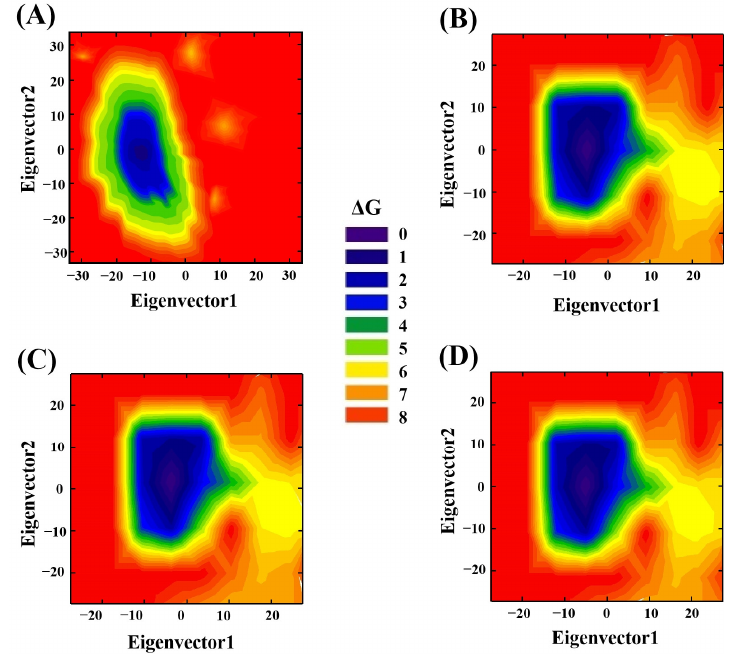
Figure 8. Principal component analysis (PCA) of single amylose molecule ( A ), complex1 ( B ), complex2 ( C ), and complex3 ( D ). The different colors in the figure legend represent different levels of energy.